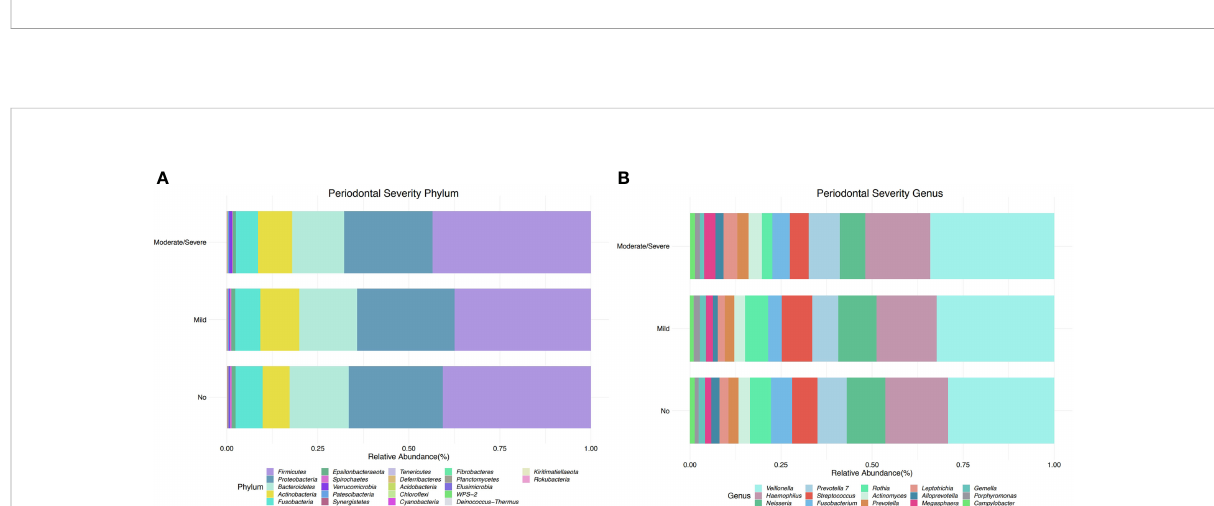
FIGURE 2 Taxonomic pro fi les of bacterial diversity by periodontal severity at phylum and genus level. (A) Taxonomic bar plot at phylum level, showing relative abundance of the most dominant taxa (FDR < 0.05). (B) Taxonomic bar plot at genus level, depicts relative abundance of the most dominant taxa (p-value <